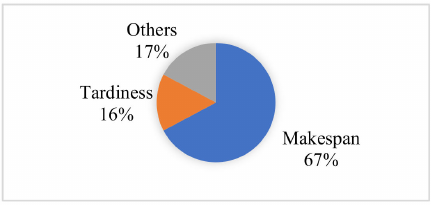
Figure 25. Percentage of different objectives (performance measures) in the dataset.